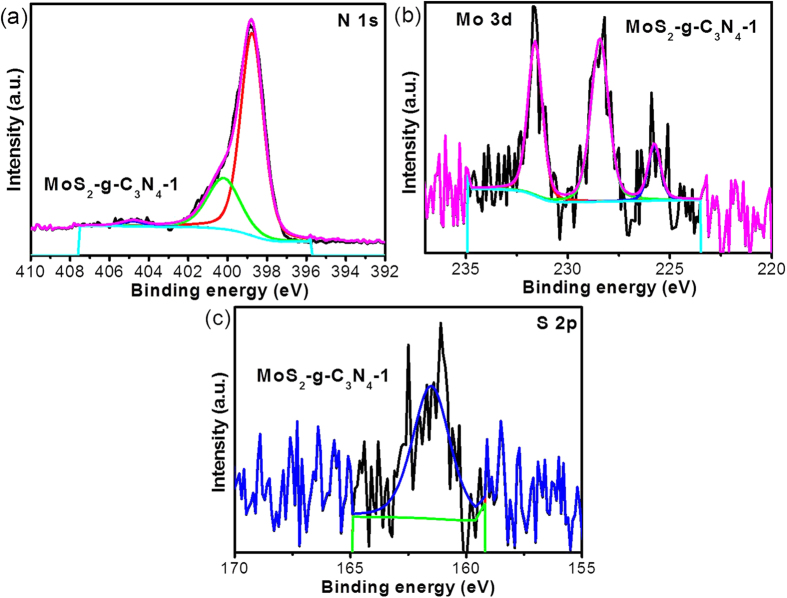
Fitted N 1 s high resolution core level spectra of (a) MoS2-g-C3N4-1, (b) Fitted Mo 3d, and (c) S 2p high resolution core level spectra of MoS2-g-C3N4-1.